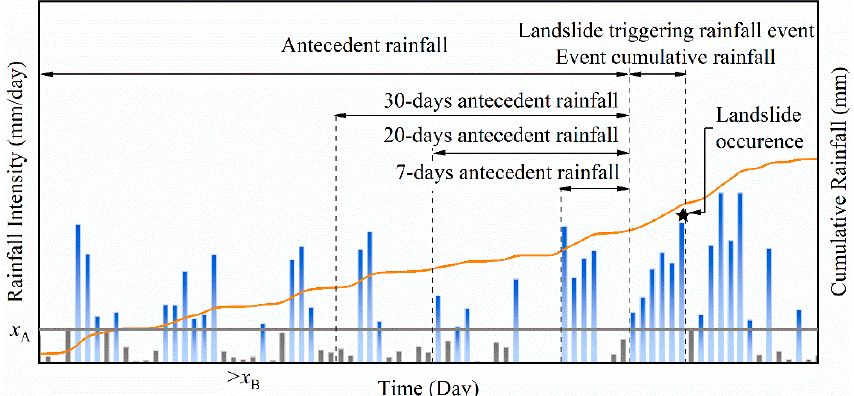
Figure 4. Definition of the criteria used to delineate between two consecutive rainfall events in this